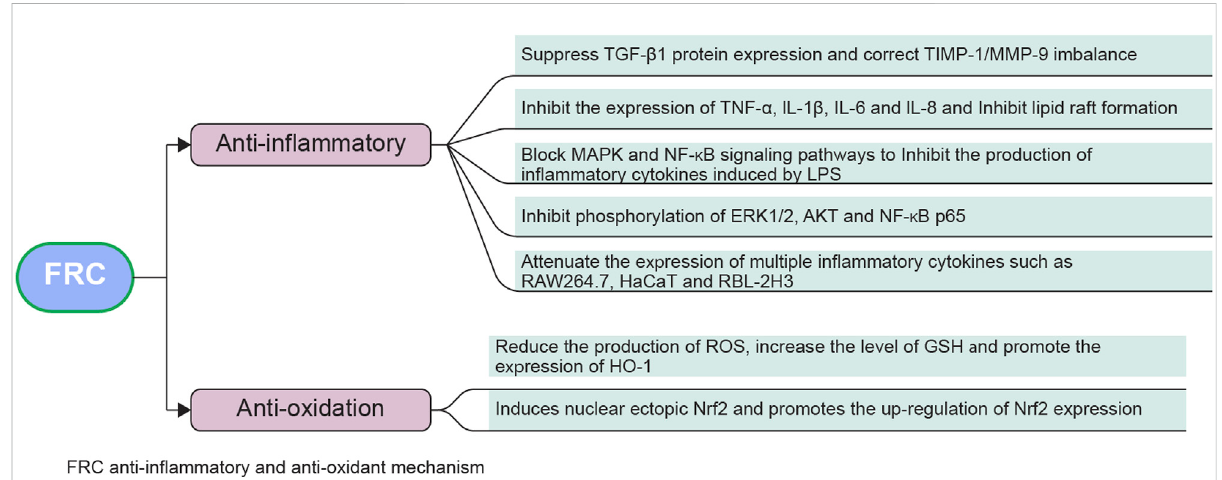
FIGURE 4 Anti-in fl ammatory and antioxidant mechanism of FRC. Abbreviations: TGF- β 1, transforming growth factor β 1; IL-1 β , interleukin-1 β ; TIMP-1, matrix metalloproteinase inhibitor-1; MMP-9, matrix metalloproteinase-9; IL-6, interleukin-6; IL-8, interleukin-8; MAPK, mitogen-activated protein kinase; TNF- α , tumor necrosis factor- α ; NF- κ B, nuclear factor-activated B cells enhanced κ -light chain; LPS, lipopolysaccharide; ERK1/2, extracellular signal-regulated protein kinase 1/2; RAW264.7, monocyte/macrophage-like cell line; AKT, protein kinase B; NF-kB p65,